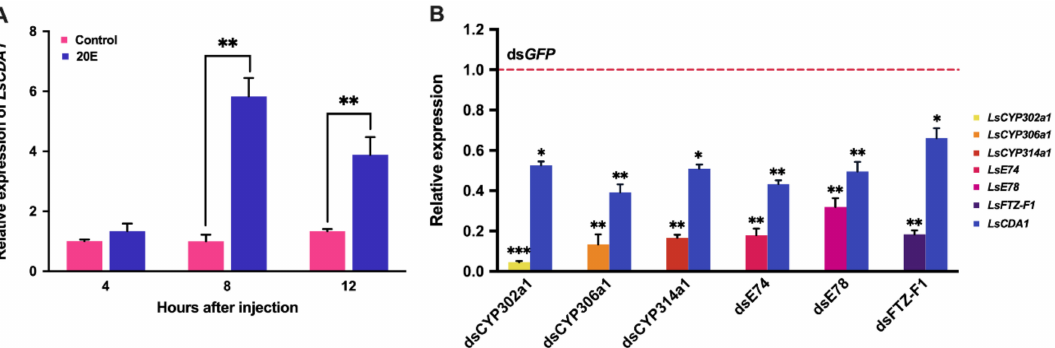
Figure 4. 20-Hydroxyecdysone-responsiveness of LsCDA1 in L. serricorne . ( A ) The in vivo e ff ects of 20E on the expression of LsCDA1 . The larvae were collected for qPCR analysis at 4, 8 and 12 h after injection with 20E. Control: insects injected with distilled water containing 0.1% ethanol; 20E: insects injected with 20E (120 ng / larva). ( B ) The relative expression levels of LsCDA1 , LsCYP302a1 , LsCYP306a1 , LsCYP314a1 , LsE74 , LsE78 , and LsFTZ-F1 at 3 days after gene-specific dsRNA injection. The gene expression in the ds GFP group was set as 1 and is shown by the dotted line. Data were normalized to the geometric mean of the expression of EF1 α and 18S . Significant di ff erences between the treatment group and control group were determined using Student’s t -test (* p < 0.05, ** p < 0.01, *** p <